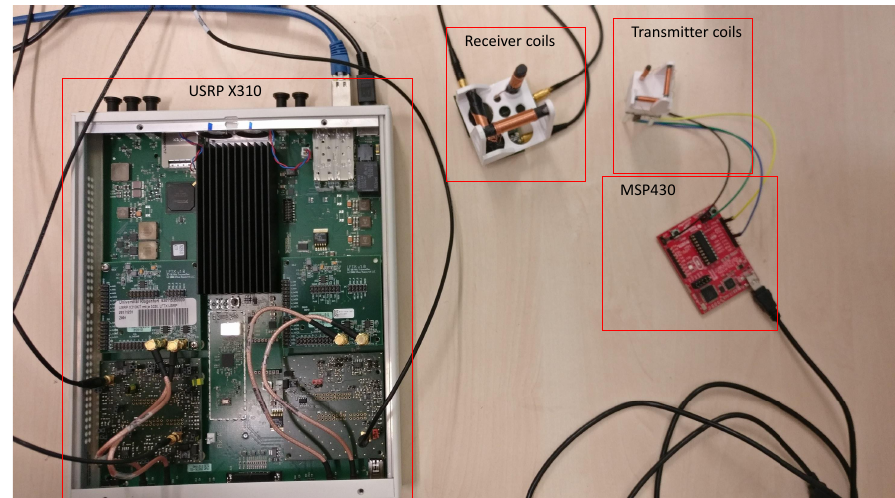
Figure 2. Laboratory prototype of the magnetic sensor. The software defined radio (USRP X310) with a custom daughter board and the receiver coils represent the artficial landmark. Only the smaller transmitter coils need to be on the UAV and the exciatation signals can easily be generated using the controller of the UAV or an additional small microcontroller such as the Texas Instruments MSP430. The equipment is sourced from the institute of the authors, in Klagenfurt, Austria.